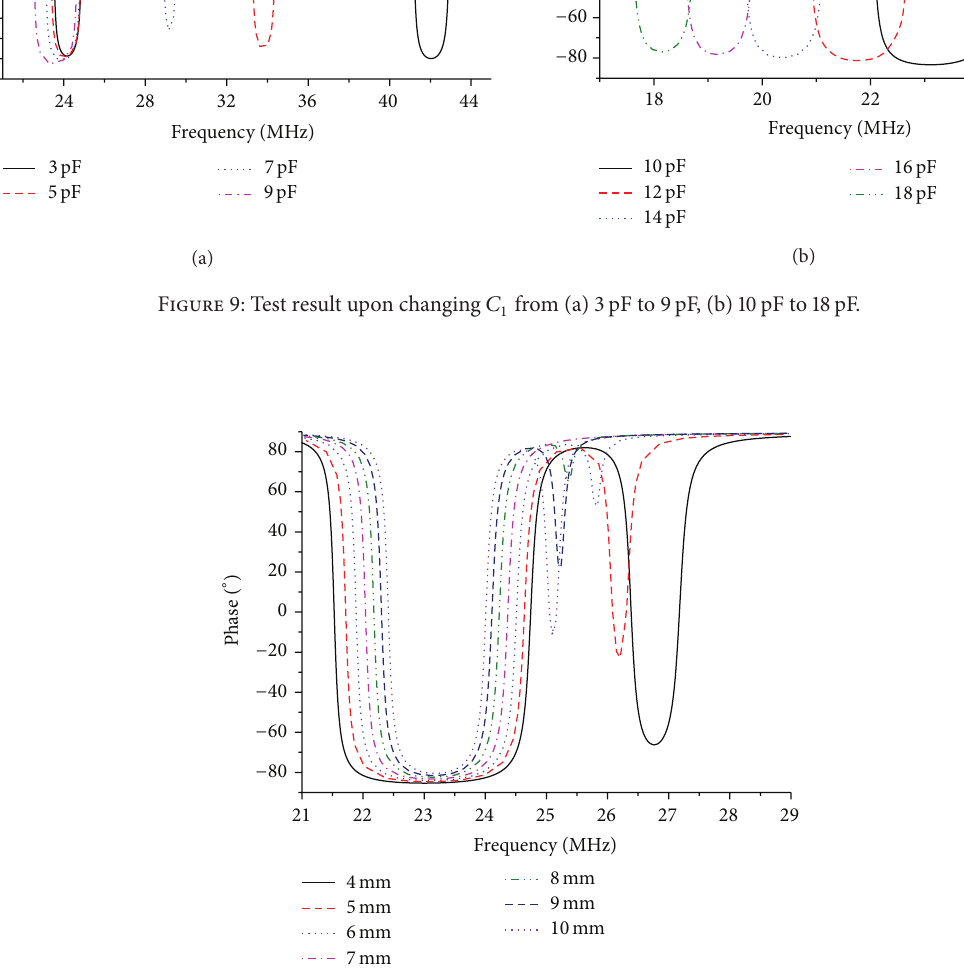
Figure 10: Test result upon moving coil 1